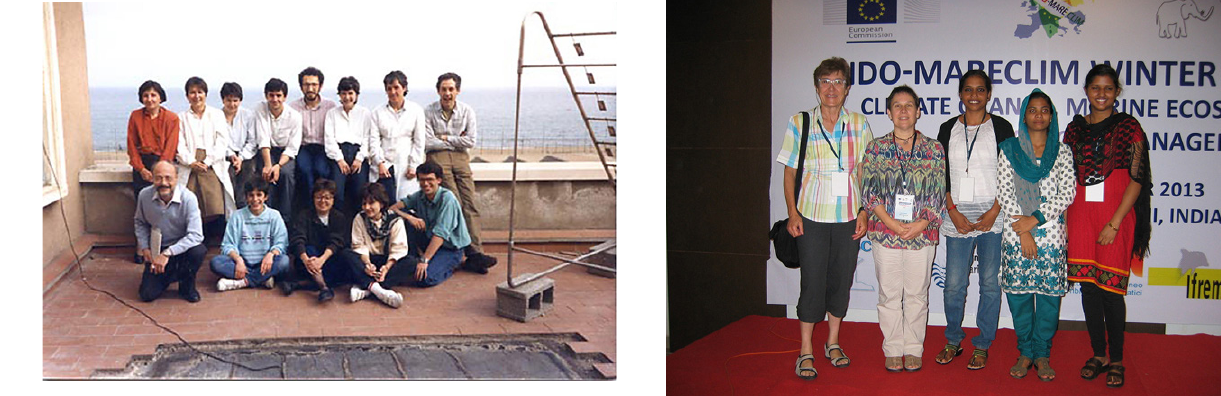
Fig. 3. – In 1988, at the terrace of the old ICM building, with several colleagues. From left to right, back line: I. Trepat, P. Andreu, E. Berdalet, E. Fernández-Suárez, E. Saiz, M. Masó, M. Estrada, J. Fig. 4. – Marta Estrada in the Indo-Mareclime Summer Course (Ko- Camp. First line: M. Alcaraz, C. Marrasé, M. Vidal, D. Vaqué, M. chi, India), November 2013, with Elisa Berdalet (on her left) and Latasa. three students.